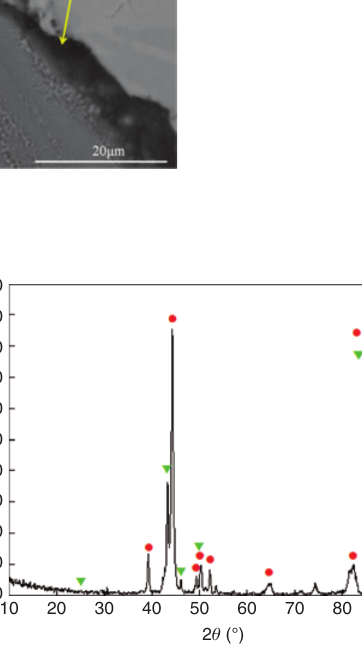
Figure 6: X-ray diffraction pattern of the metal between ceramic